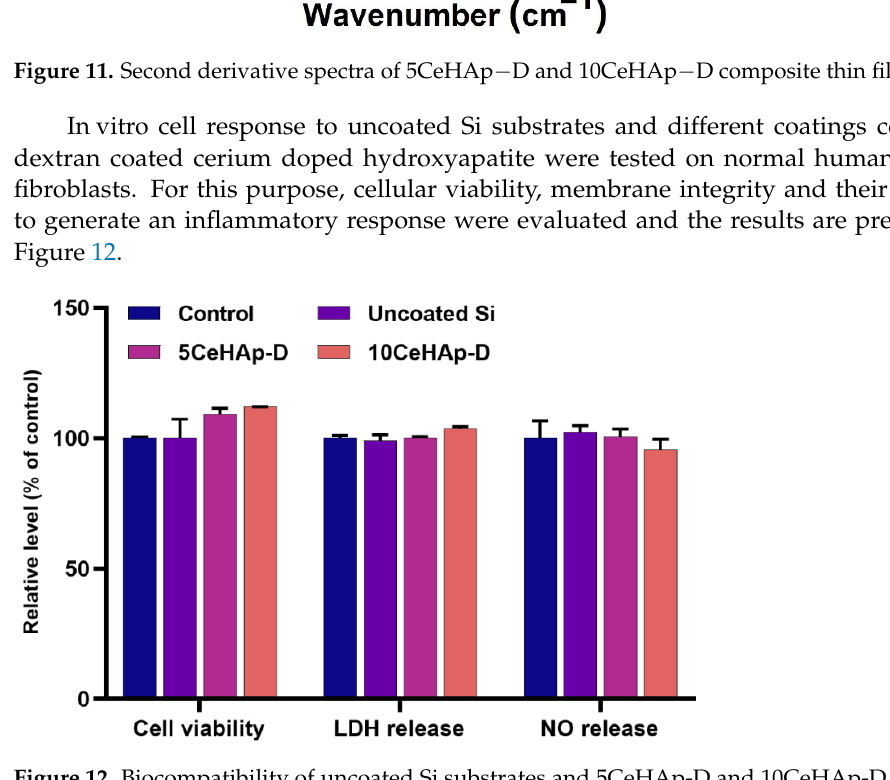
Figure 12. Biocompatibility of uncoated Si substrates and 5CeHAp-D and 10CeHAp-D composite coatings as shown by cell viability, lactate dehydrogenase (LDH), and nitric oxide (NO) release assays after 24 h exposure on normal gingival fibroblasts. Results are expressed as the mean ± standard deviation (SD) ( n = 3) and represented relative to the untreated cells (control).